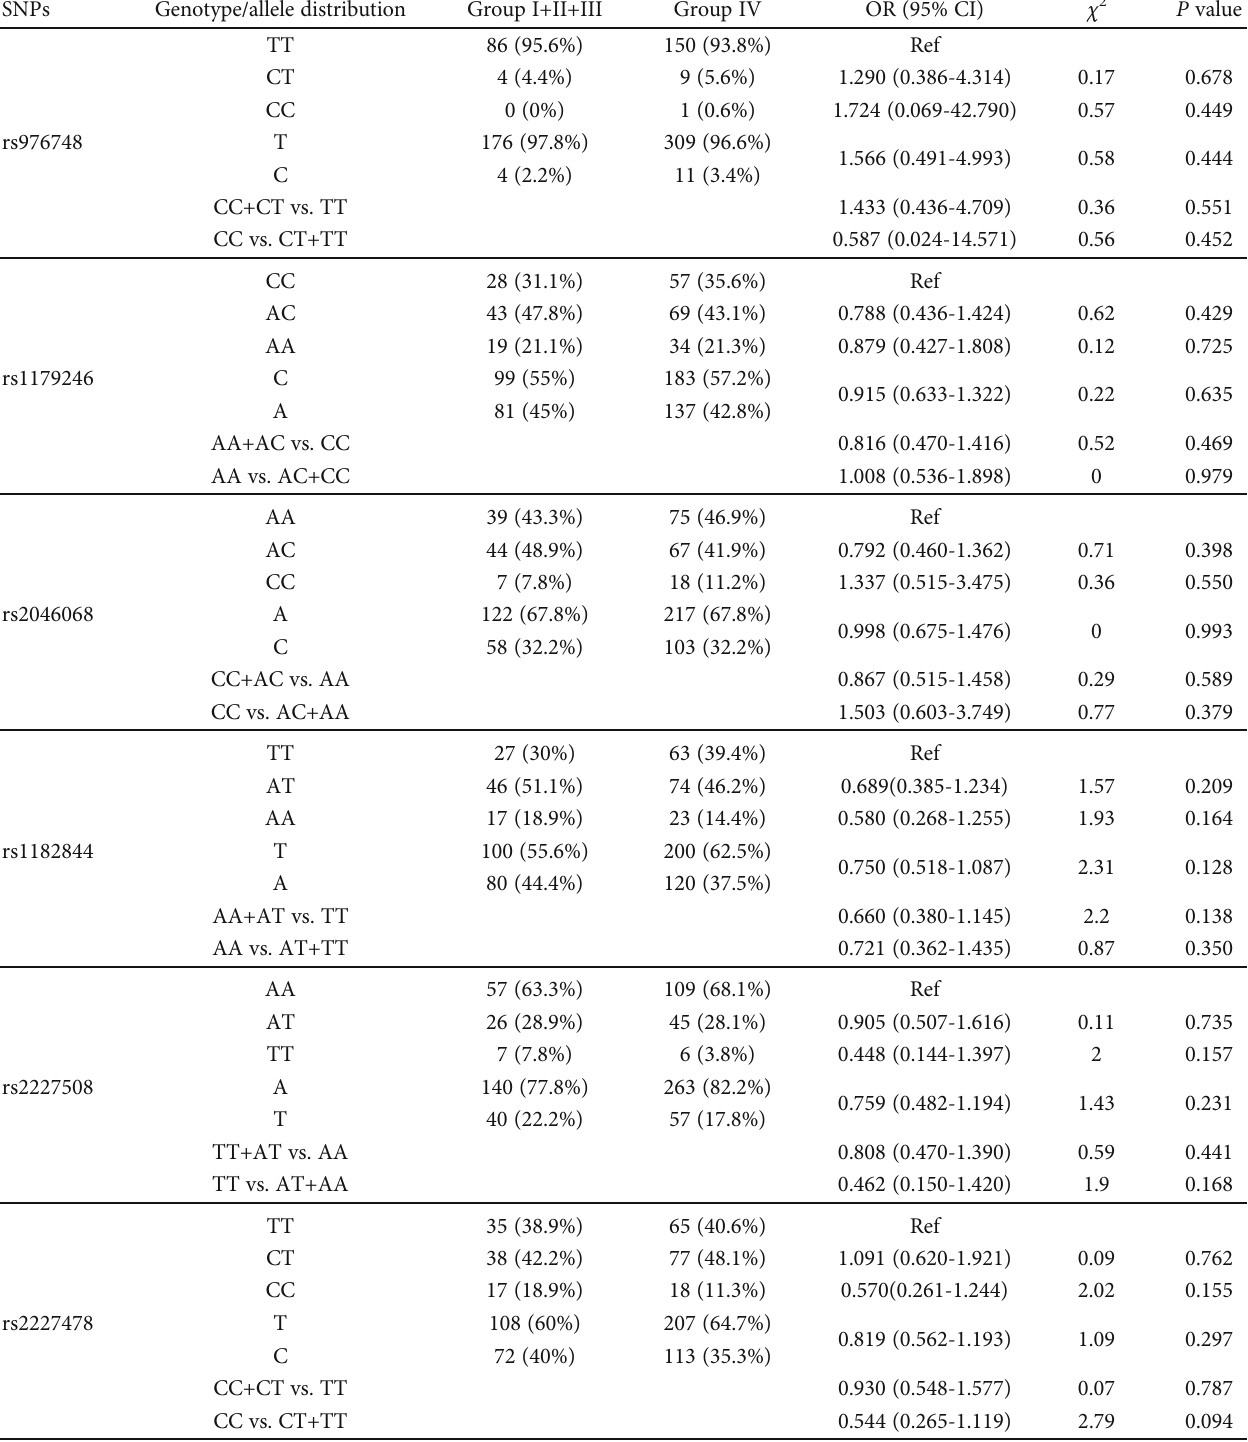
Table 2: Genotype distribution and allele frequency of IL-22 SNPs in group I+II+III of parasite density compared to group